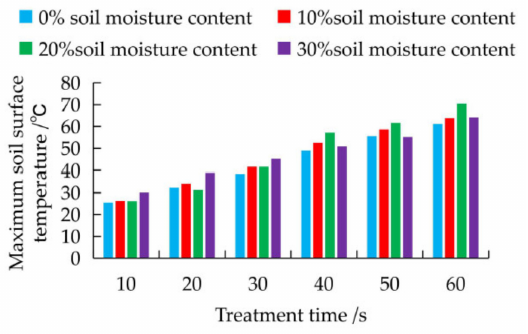
Figure 14. Soil surface temperature under 1.8 kW microwave output